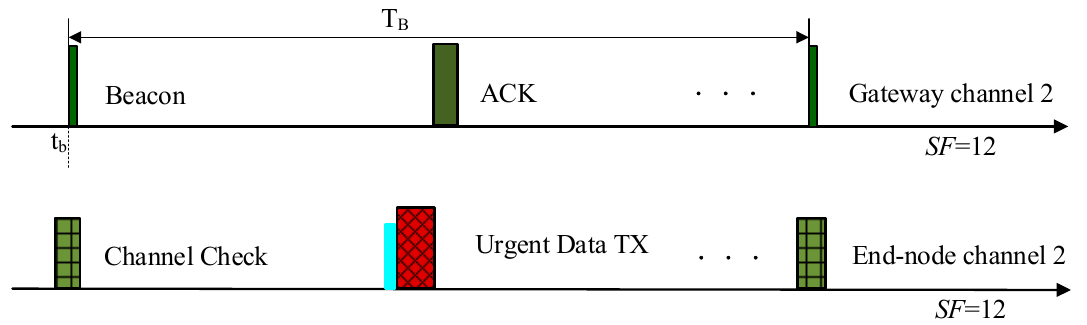
Figure 11. Beacon and urgent packet sending on channel 2.